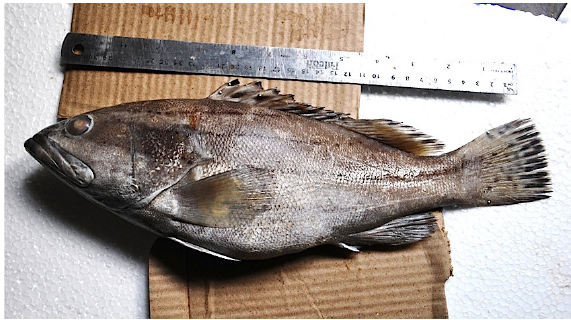
Image 3. Striped Grouper Epinephelus